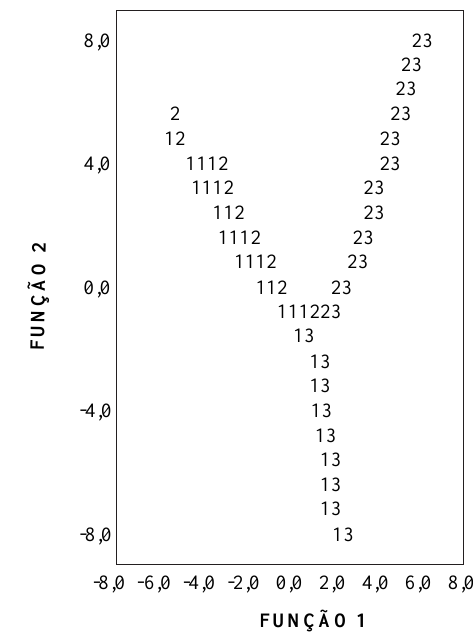
Figura 1. Mapa territorial das três classes de quali- dade de sítio, gerado pelo modelo